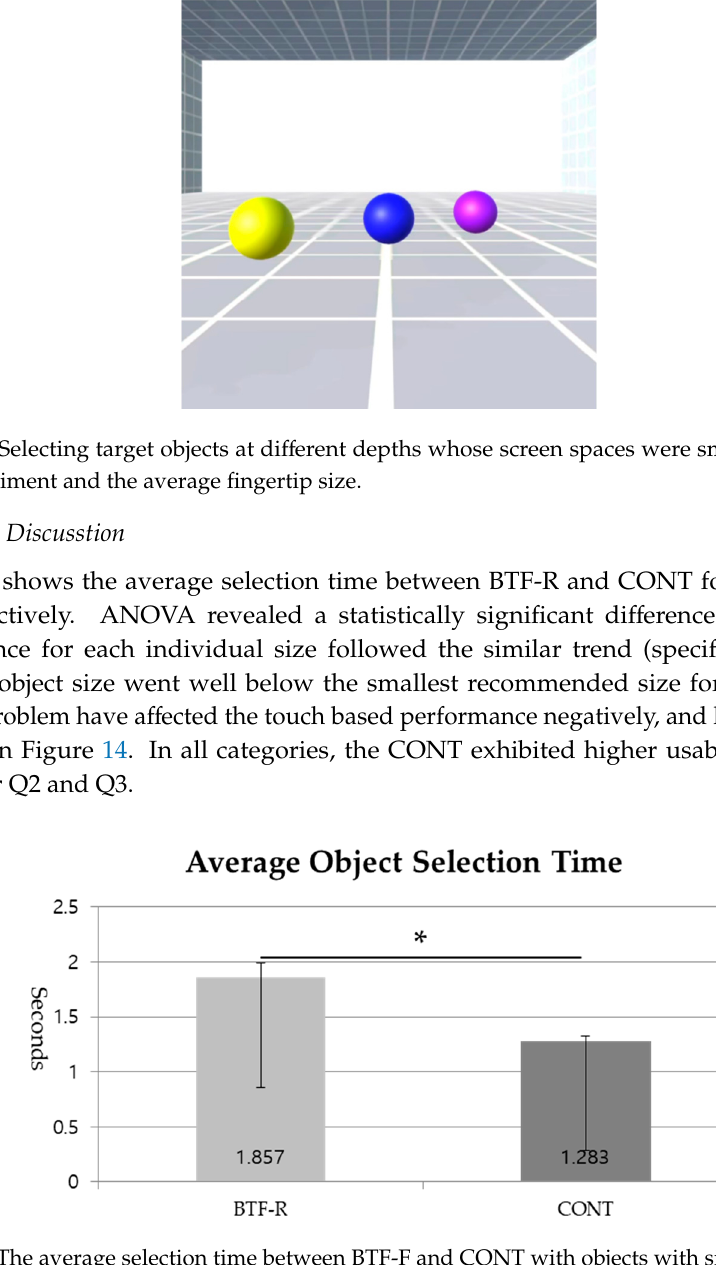
Figure 14. Responses to the usability survey for selecting objects with sizes below 0.4 cm between BTF-R and CONT. The asterisk mark (*) indicates statistically significant difference. More seriously, our observation and post-briefing revealed that the subjects had quite a difficulty in fusing the stereoscopic imagery with the EasyVR set-up, contrast to the main experiment in which no such phenomenon occurred. For some reason, subjects had trouble being able to focus on the small objects as laid out at different depth. This goes to show that additional interface would be needed to resolve this problem. 7. Conclusions In this paper, we proposed, Blurry Touch Finger, a touch screen based interaction technique an open mobile VR platform with fingers accessible to the screen. We emphasize that the main objective was to show effectiveness of BTF on EasyVR (not EasyVR itself as a framework), as a viable alternative to existing selection method like the gaze/button and even controller based ray-casting methods. Our work partly demonstrated the utility of the proposed method; the object selection performance was as good as when using head-directed and the hand-driven ray casting methods. Binocular rivalry is usually a phenomenon that affects the visual perception in a negative way. The blurriness caused by the rivalry incidentally made it possible for the user to look through the finger, and added by the sense of proprioception, and accurately select the wanted object. In addition, such touch based selection is already a quite familiar task through the usual interaction with the smartphones. However, even with the after-release technique and the see-through nature of the “blurry” touch selection, for objects fairly below the size of the fingertip, the touch based performance